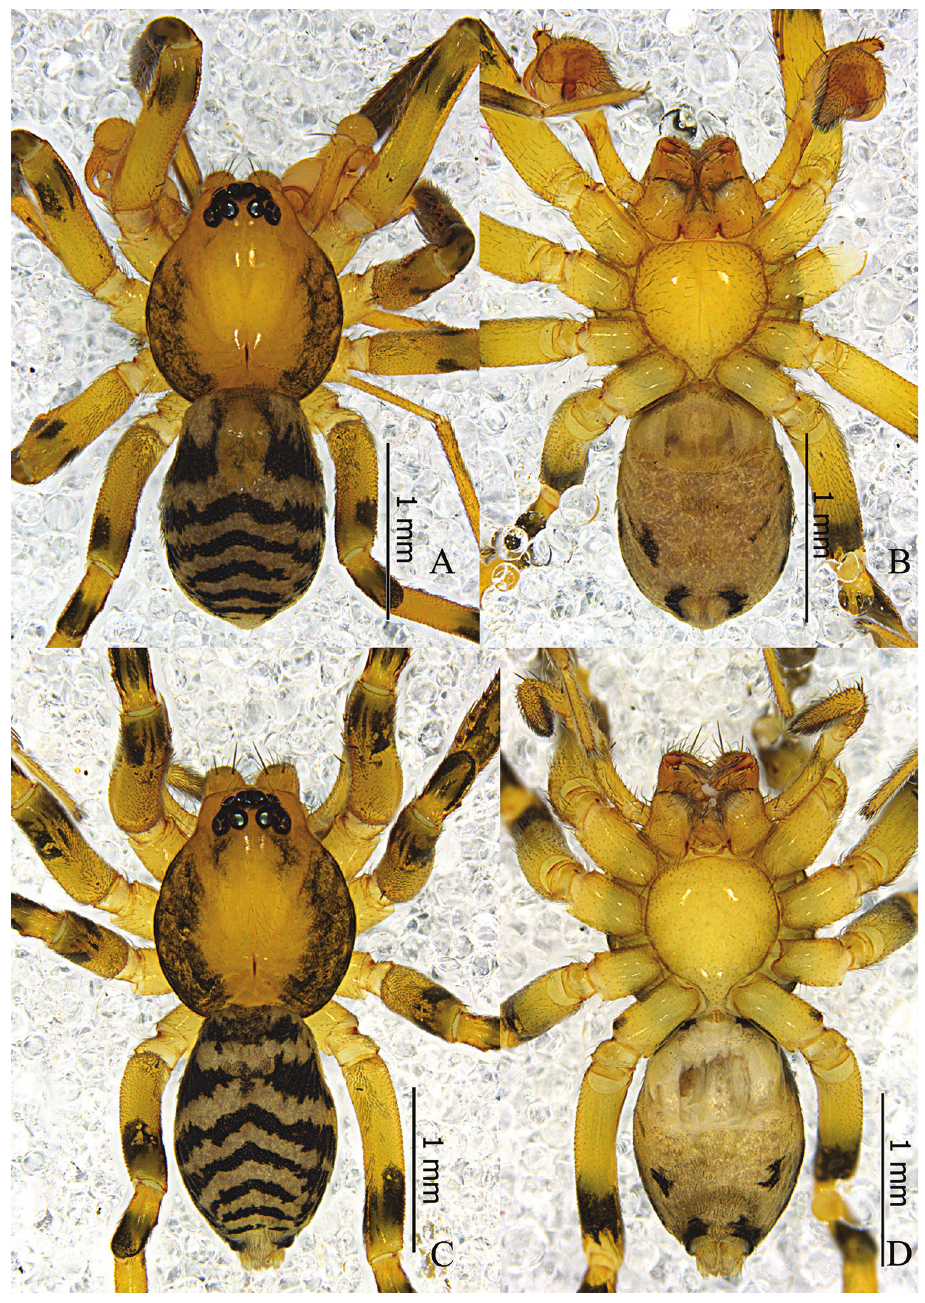
Figure 1. Otacilia hippocampa sp. n. A male habitus, dorsal view B same, ventral view C Female habitus, dorsal view D same, ventral